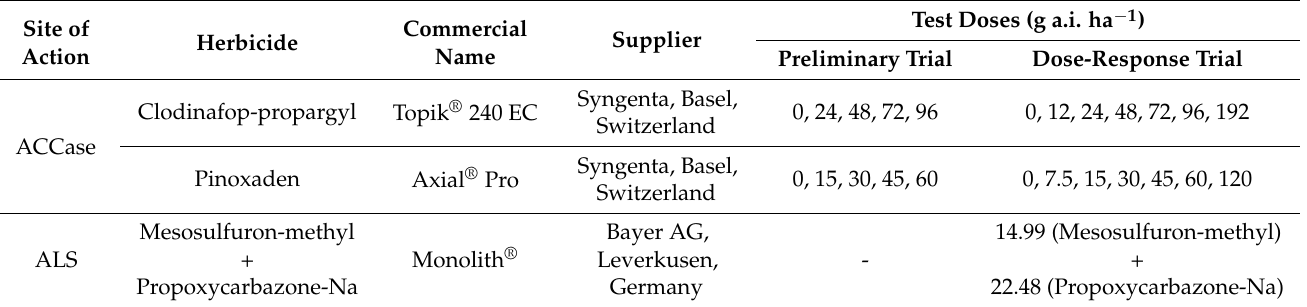
Table 1. Details of the herbicide treatments applied in the dose-response experimental